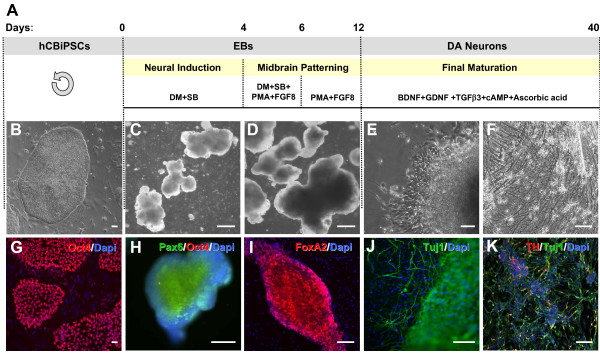
Sequential induction of hCBiPSCs towards dopaminergic neurons. (A) Schematic summary of the differentiation procedure. Phase-contrast images (B-F) and immunocytochemical stainings (G-K) during in vitro differentiation. Oct4-positive hCBiPSC colonies (B,G) were detached from the feeder layer and cultured in suspension as embryoid bodies (EBs) in the presence of dorsomorphin (DM) and SB 431542 (SB) for six days. During this time Oct4 expression was completely lost, whereas cells started to express the neural stem cell marker Pax6 (H). On day 4, purmorphamine (PMA) and FGF8 were added to initiate regionalization. After 12 days the vast majority of EBs coexpressed the midbrain marker FoxA2 (I). EBs were plated on PLO/laminin-coated cell culture dishes on day 12. Tuj1-positive neuronal cells spread out (J) and maturated into numerous dopaminergic (DA) neurons in the presence of BDNF, GDNF, TGFβ3, cAMP and ascorbic acid as indicated by tyrosine hydroxylase (TH)-positive cells (K). Scale bars represent 100 μm. FGF8, fibroblast growth factor 8; hCBiPSC, human cord blood induced pluripotent stem cells.